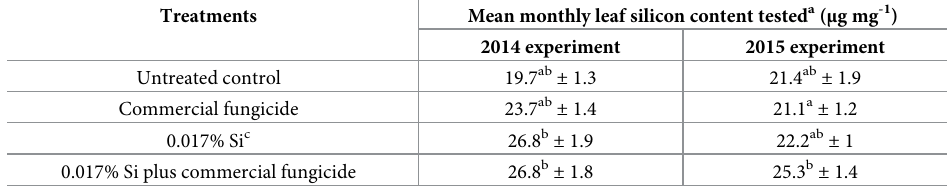
Table 4. Mean monthly leaf silicon content ( μ g mg -1 ) from each treatment in 2014 (08 April-23 September) and 2015 (21 April-29 September) experiments.